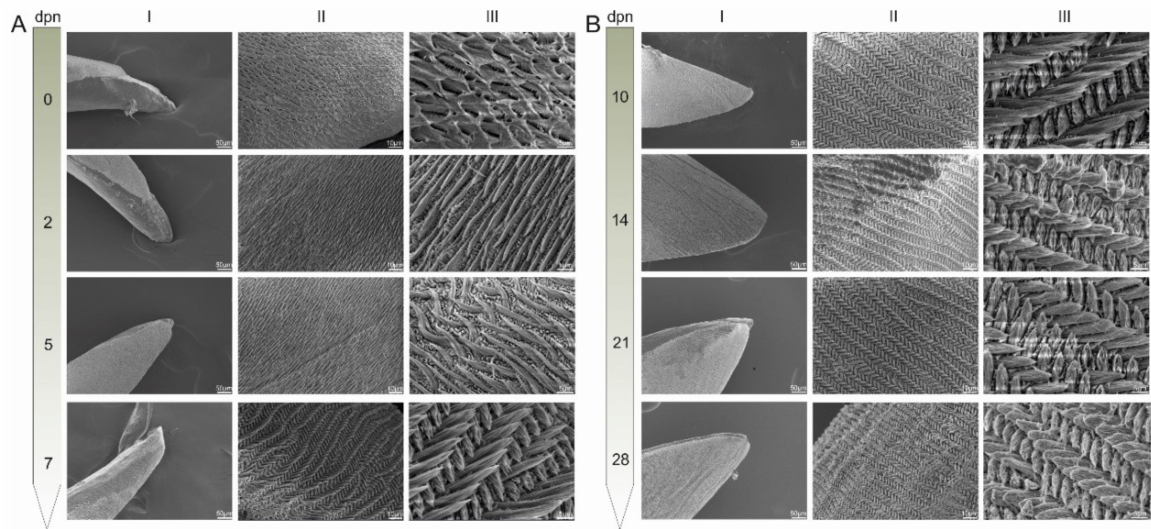
Figure 2. SEM images of incisor tip (I, mag. 500 × ) and etched enamel surface (II, mag. 2500 × , III, mag. 10,000 × ) pictured in 0th, 2nd, 5th, 7th ( A ) and 10th, 14th, 21st and 28th ( B ) day of postnatal life